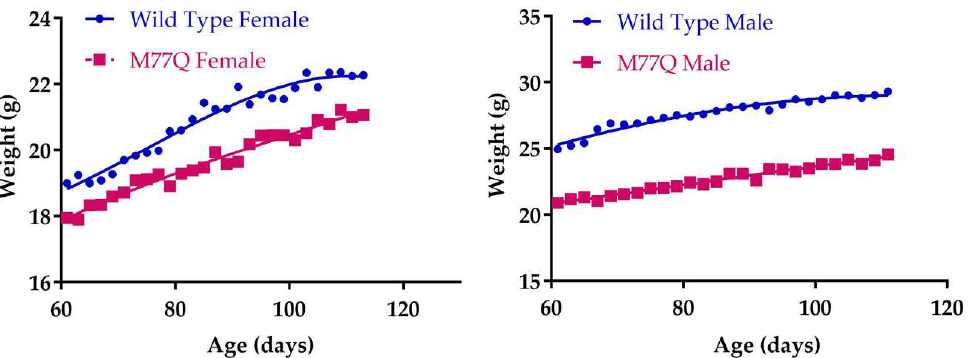
Figure 3. Growth curves. There were 7 mice in each group.